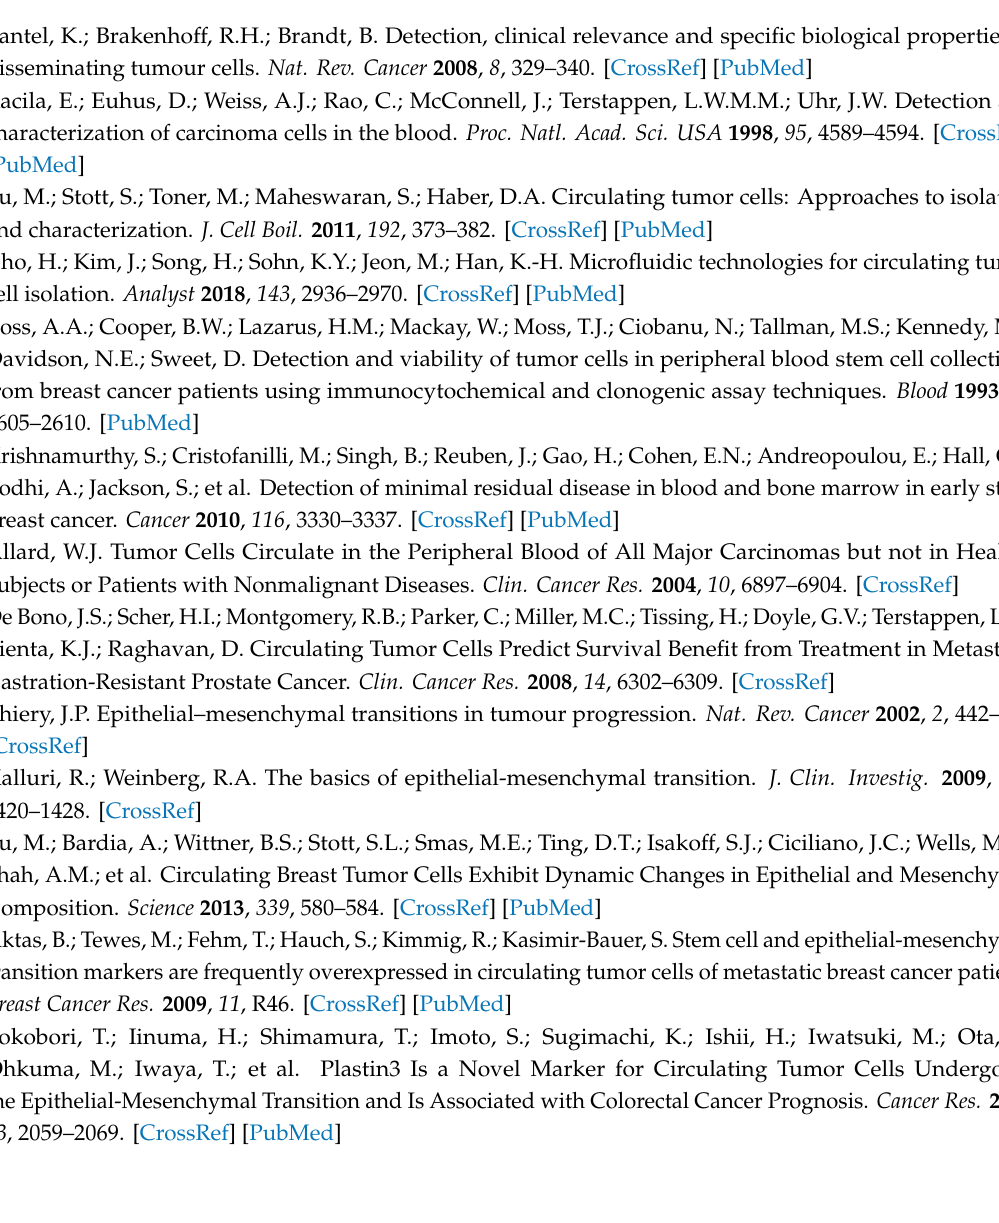
Figure S1: Fabrication process for the PosCTC- µ Chip, Figure S2: Fabrication process for the NegCTC- µ Chip, Figure S3: EpCAM expression level of cancer cell lines